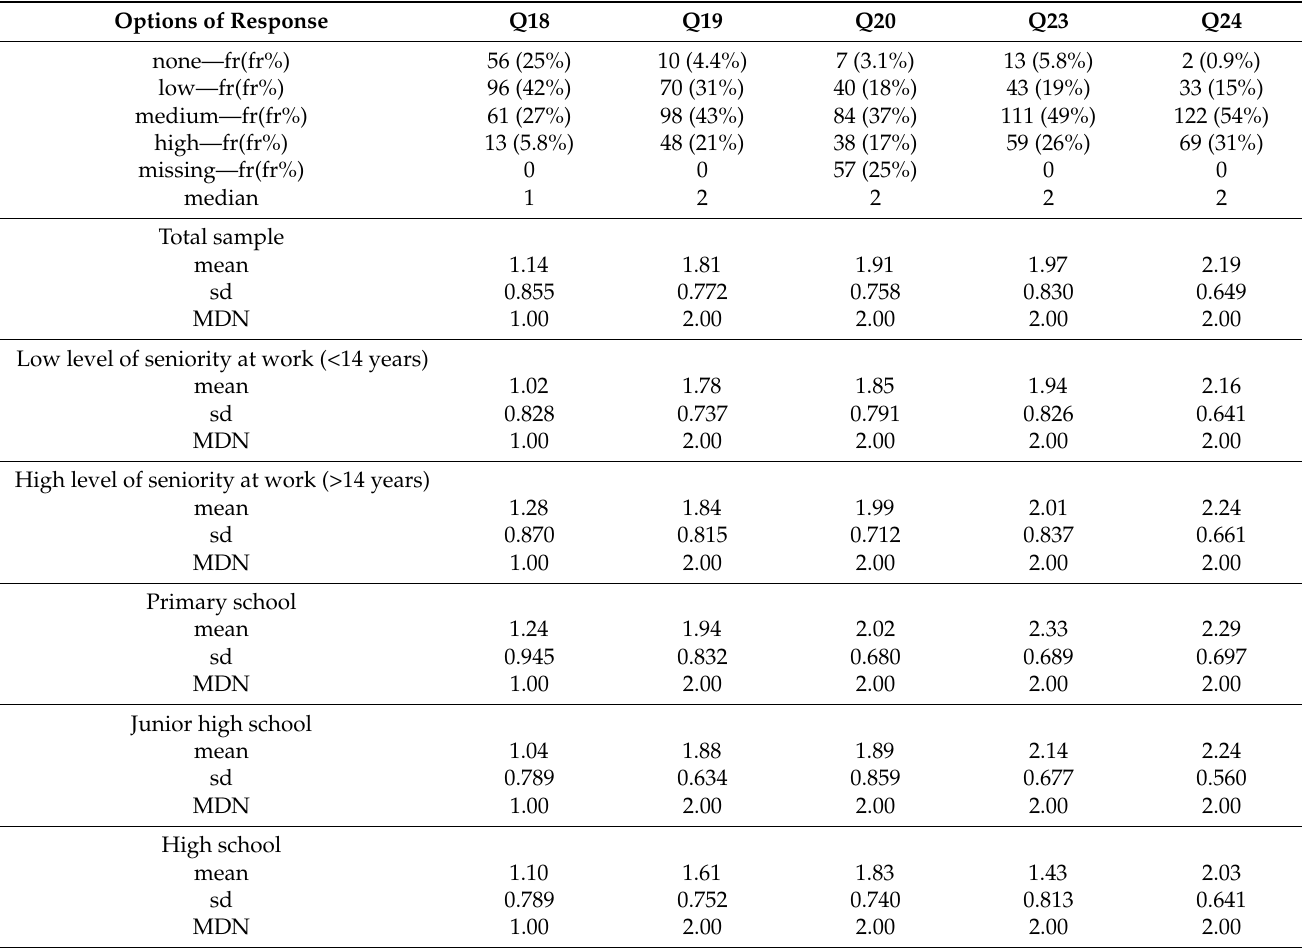
Table 6. Level of difficulty perceived by teachers in using digital